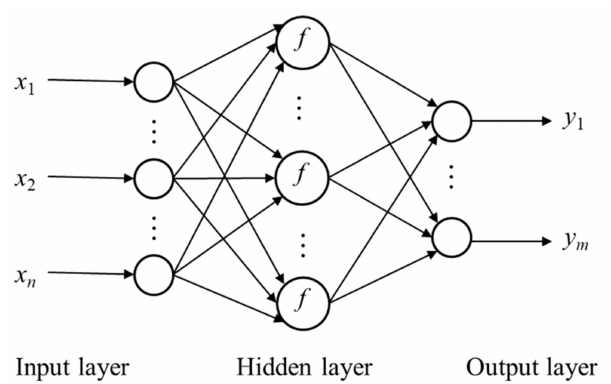
Figure 5. Architecture of a typical three-layer